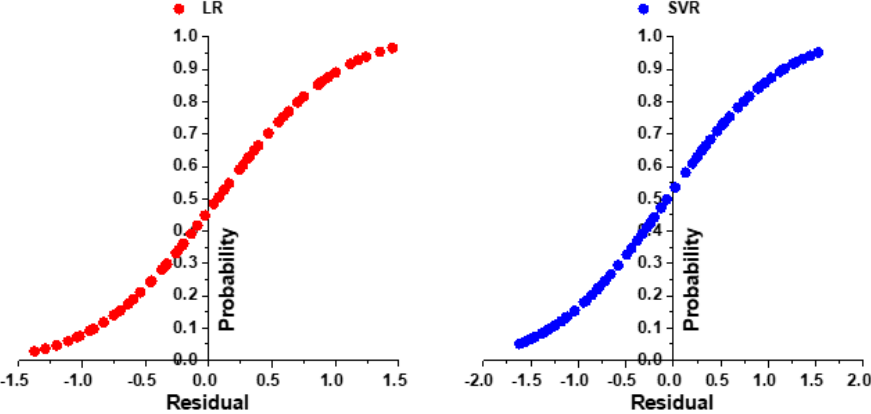
Figure 9. Cumulative distribution analysis from measured and predicted data using LR and SVR models.